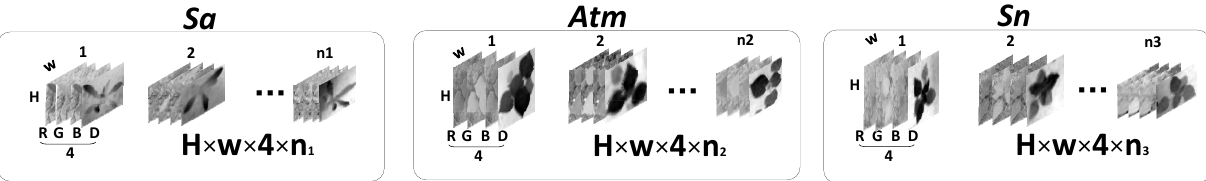
Figure 8. YOLO-V4 output data stream. In this figure, H × W × 4 × n, H, W indicate the size of the cropped image of each weed detected, 4 represents the number of RGB-D channels, n represents the number of each weed in the picture, each type of weed. The number of grass is different, n1, n2, and n3 are used to indicate